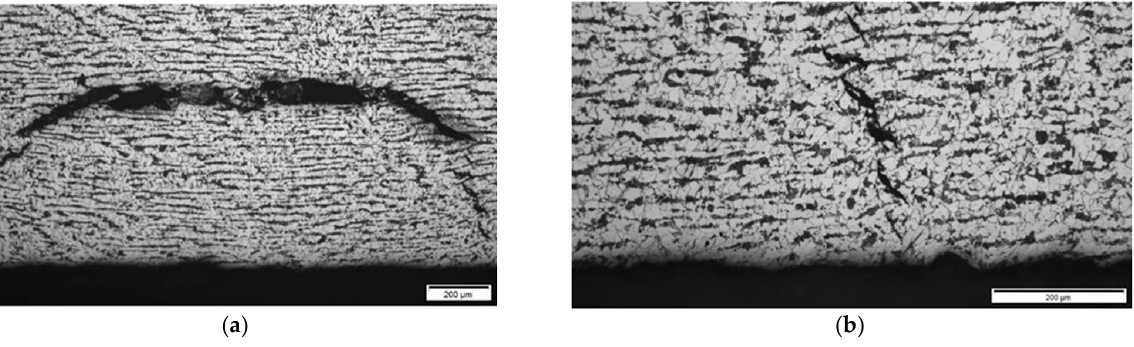
Figure 27. Section No3: 142–198. Coordinate 193 mm, blistering cracking magnification ×100 ( a ), stepwise cracking connected to ID, magnification 200× ( b ).